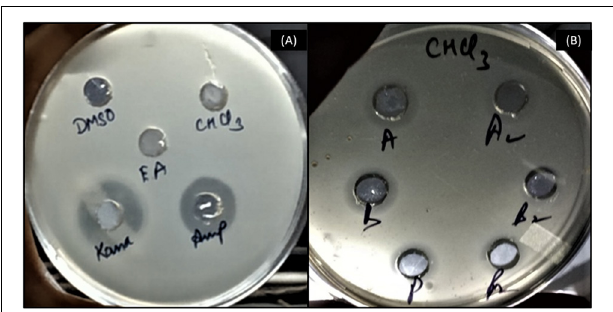
FIGURE 3 | Evidence of inhibitory activity of bioinoculant species’ supernatant extracts in an agar plate diffusion assay. (A) negative controls (uninoculated medium extracted with DMSO, chloroform and ethyl acetate) and positive controls (kanamycin and ampicillin); (B) chloroform extracts from culture of A. chroococcum alone (A), co-culture of A. chroococcum and L. monocytogenes (A2), culture of B. megaterium alone (B), co-culture of B. megaterium and L. monocytogenes (B2), culture of P. fluorescens alone (P), and co-culture of P. fluorescens and L. monocytogenes (P2).